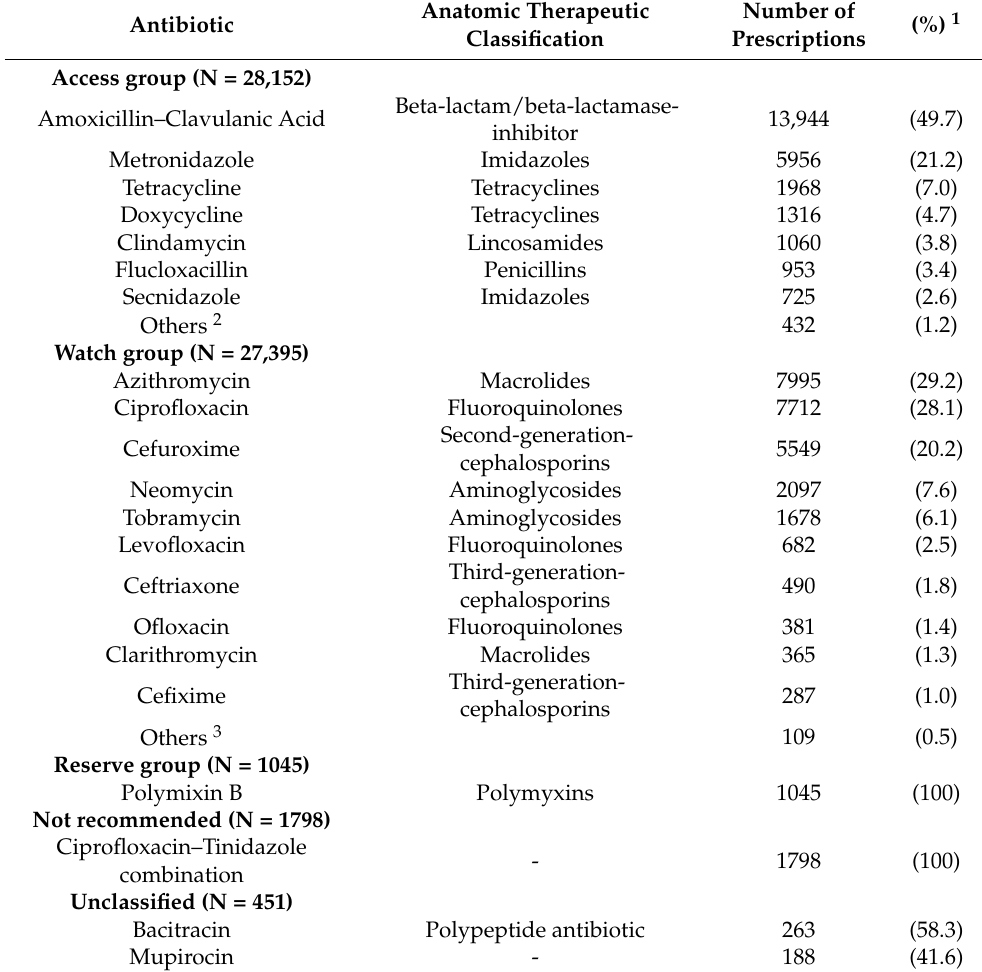
Table 3. Pattern of antibiotic prescriptions in the outpatient department of University Hospital, KNUST, in Ghana between January and December